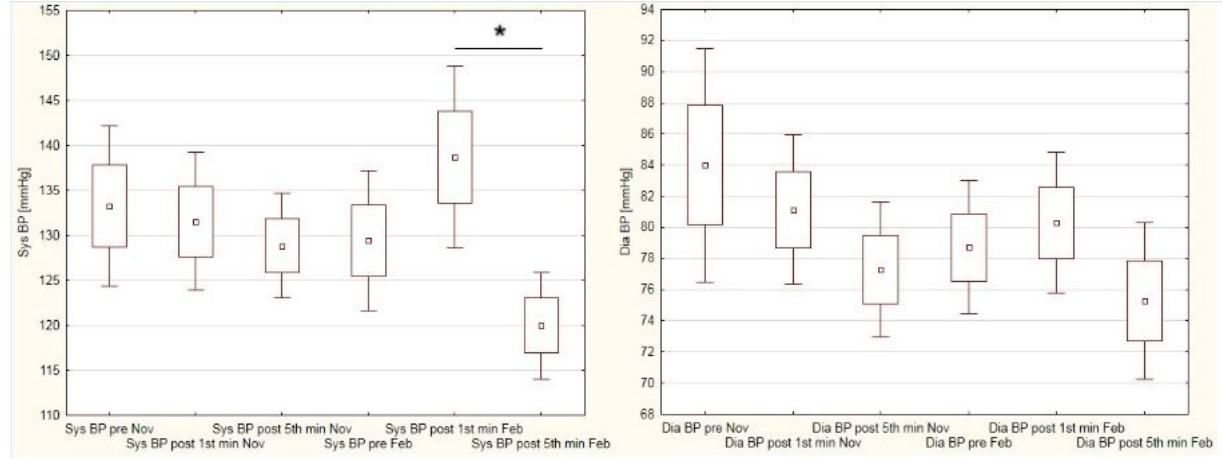
Figure 4. Blood pressure variations in male students in autumn and winter sessions of Physical Work Capacity 170 test. * p < 0.05.